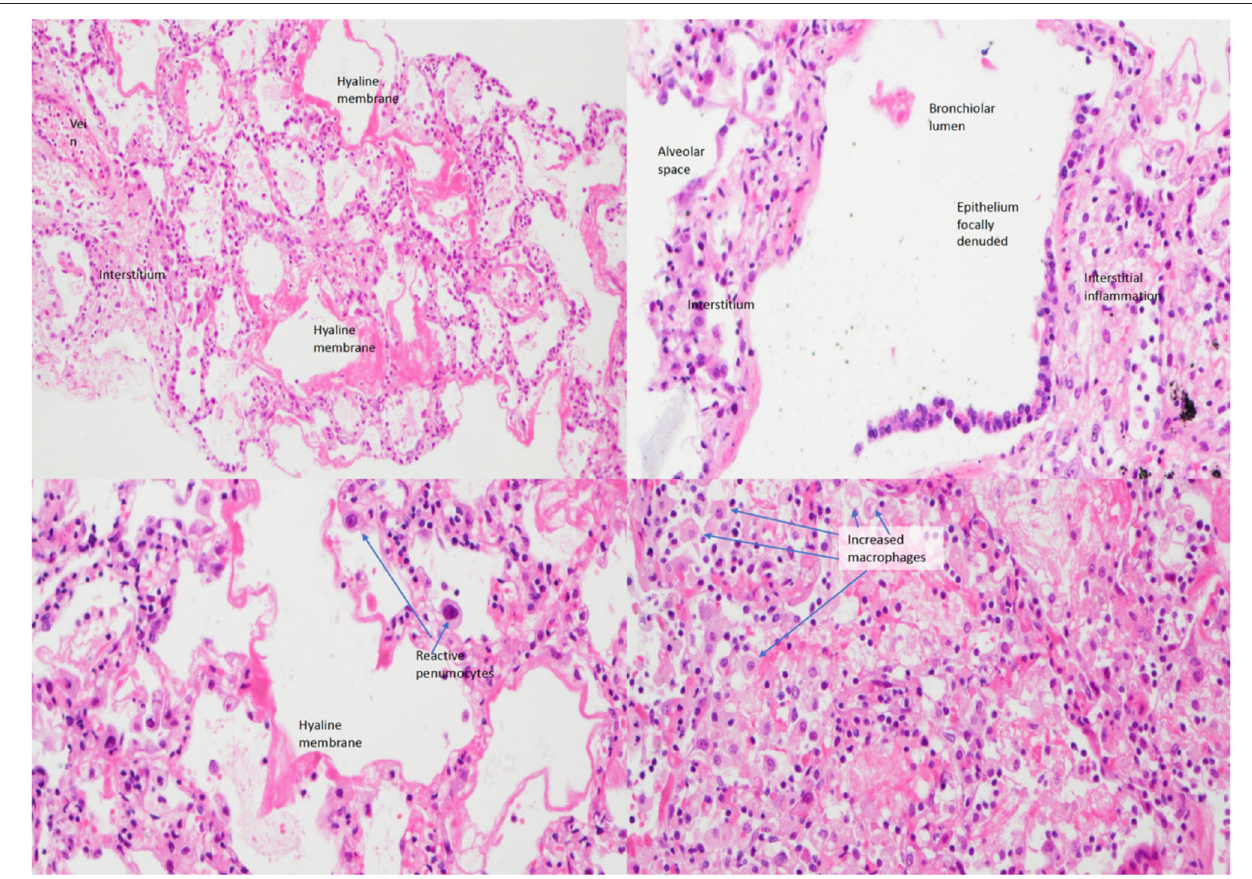
FIGURE 1 | Lung biopsy of the patient under low power (left upper figure), medium power (right upper), and high power (left lower and right lower) showing interstitial inflammation, infiltration of macrophages and reactive pneumocytes with evidence of diffuse alveolar damage.